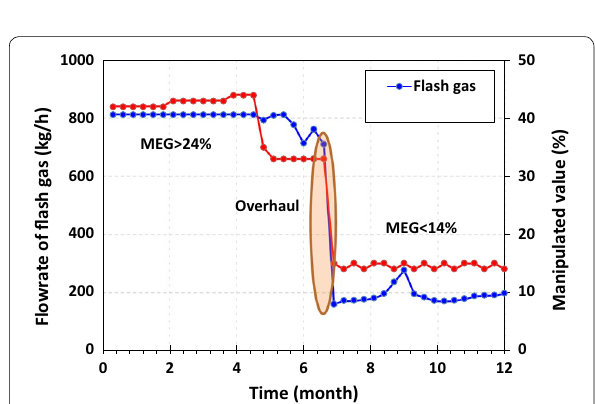
Fig. 13 Flash gas from the flash drum and LV0036 opening overhaul: scheduled shutdown